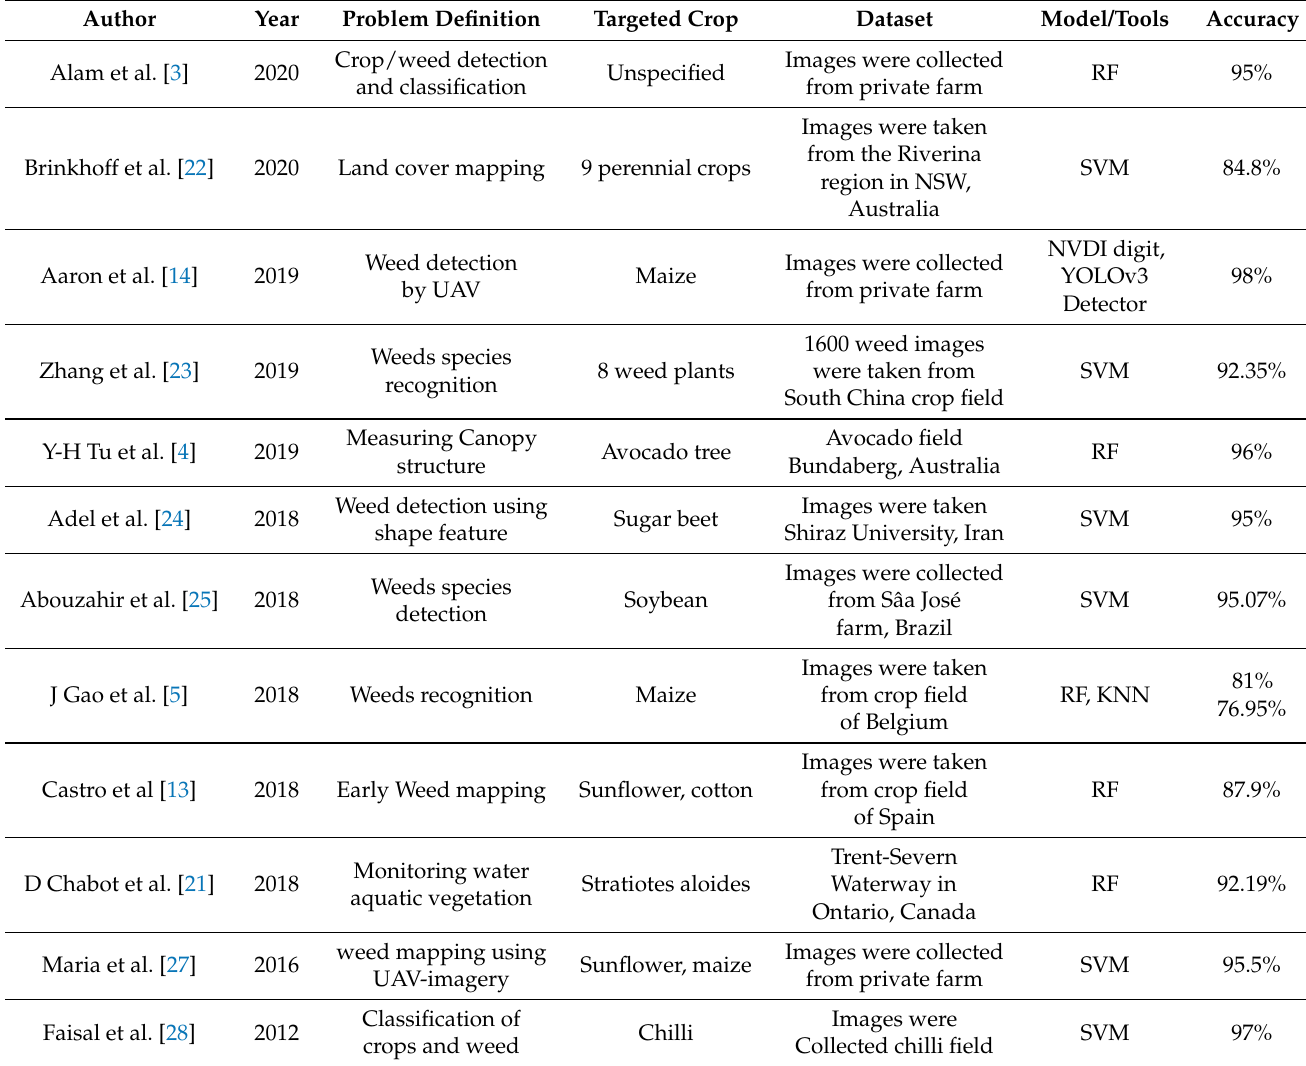
Table 1. Machine learning techniques for weed